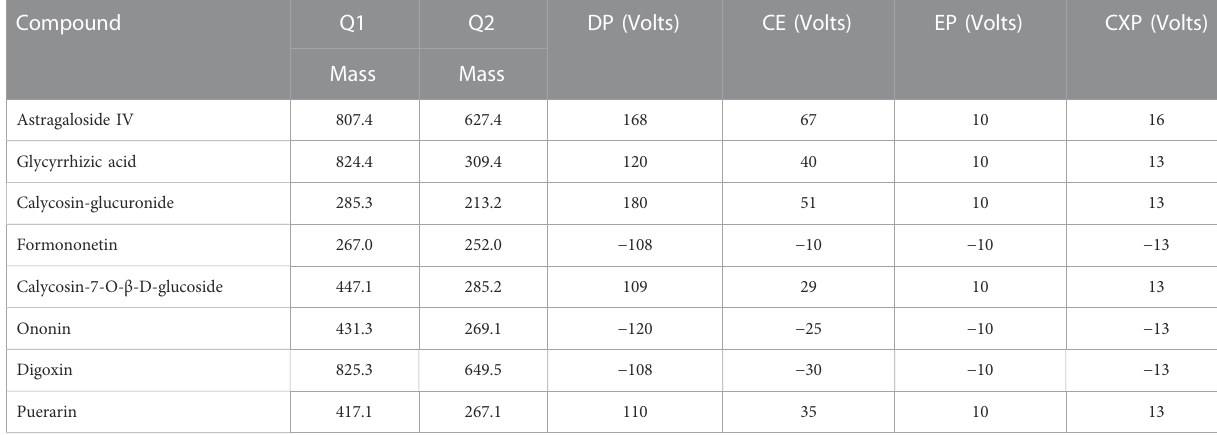
TABLE 2 Mass spectrum parameters of HPLC-MS/MS.